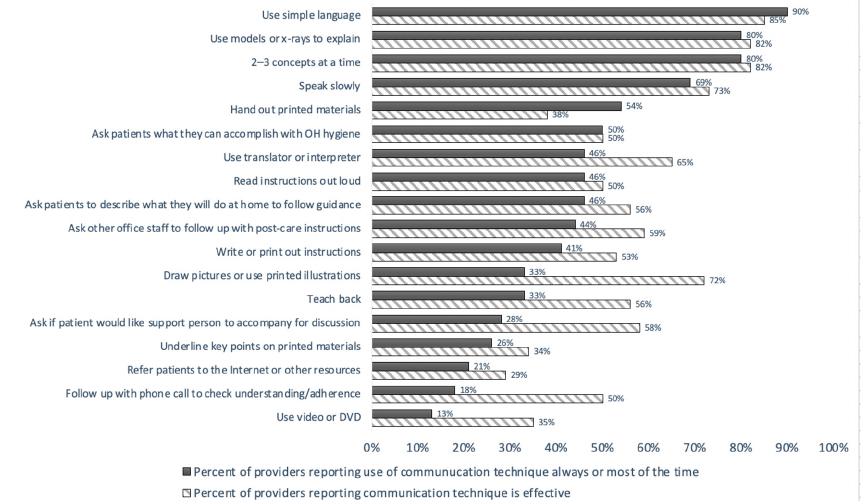
Figure 1. Use and effectiveness of American Medical Association’s 18 communication techniques in practice ( n = 40). Assessment of provider use and perceived effectiveness of AMA’s 18 communication techniques; see Rozier et al., 2011, for previous assessment of these techniques in practice by oral health providers.